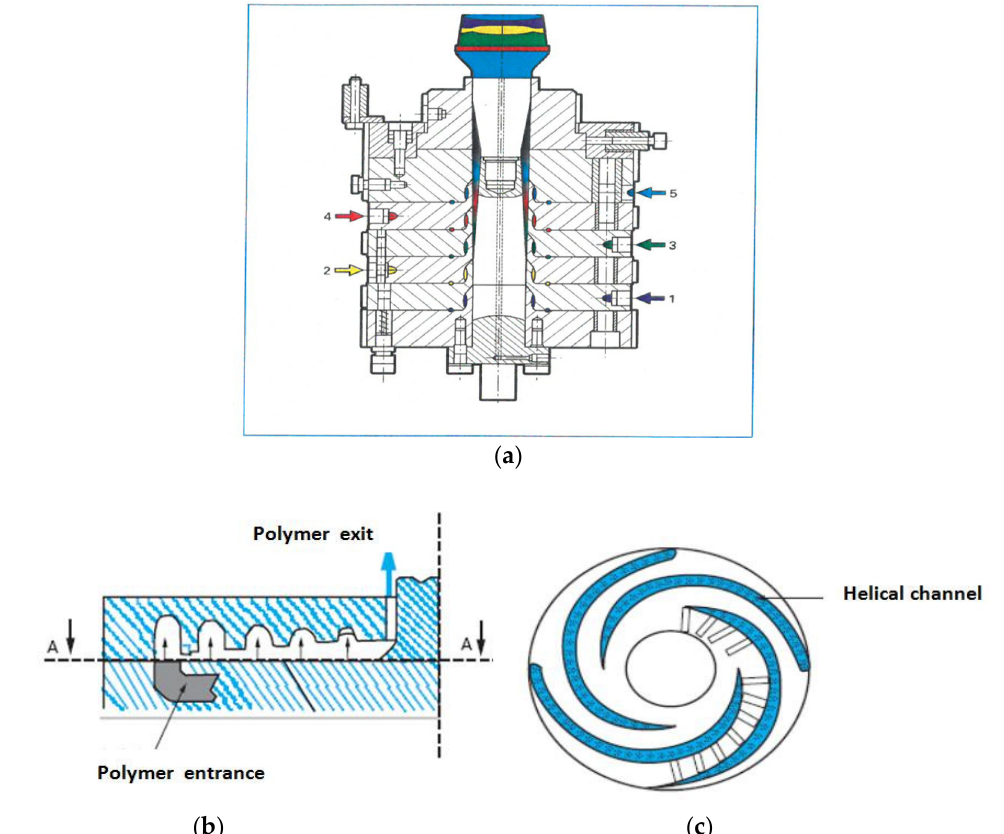
Figure 2. Example of a pancake die geometry; ( a ) stack of five pancake dies, ( b ) cross-section, ( c ) section AA (Reprinted from Ref. [2]).